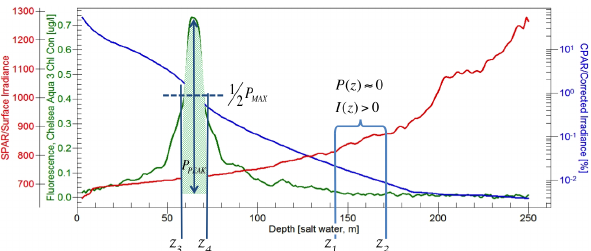
Figure A1. CTD data at Station 7 (36.3 ◦ N 13.5 ◦ W) 21 July 2009, 11a.m. Depth profile of the Chl a concentration (green line), depth profile of the corrected irradiance (blue line), and surface irradiance at the time of the measurement at depth (red line). The light blue lines indicate the depth section used to extract K bg . The green-shaded area symbolises the phytoplankton concentration which is used to determine k .